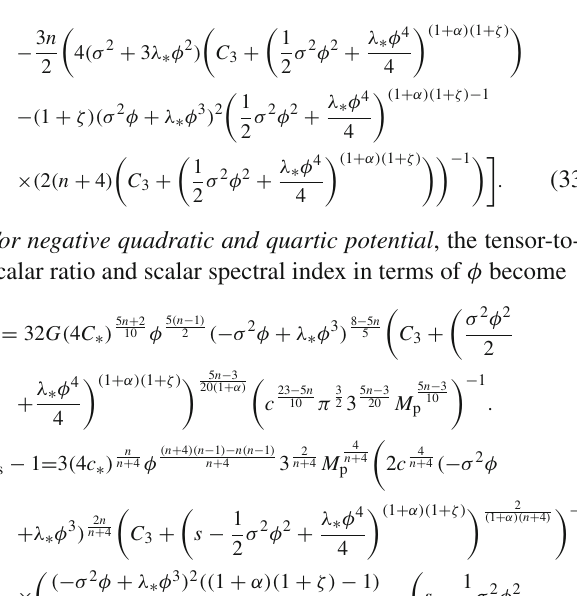
Fig. 8 Plot of r versus n s for MCG model in weak (left panel) and strong (right panel) dissipative regimes for positive potential with n = −